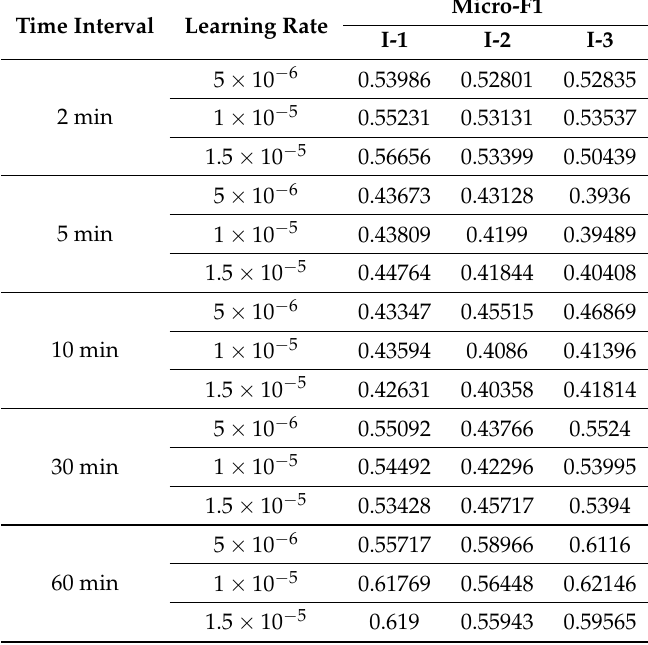
Table 5. Mean micro averaged F1 testing results of all events that are obtained using leave-one-event-out cross-validation along T by varying learning rate.